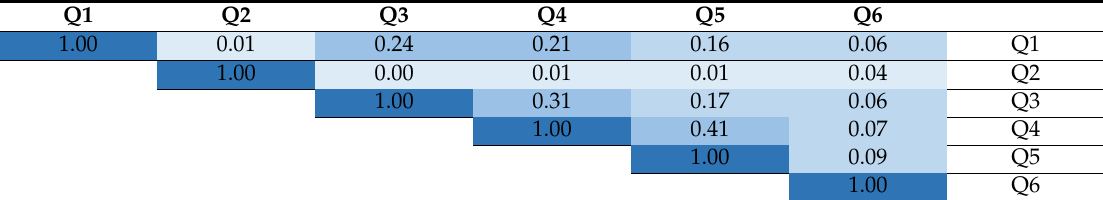
Table 3. Correlation between survey questions regarding pharmacogenomics. Q1 Q2 Q3 Q4 Q5 Q6 1.00 0.01 0.24